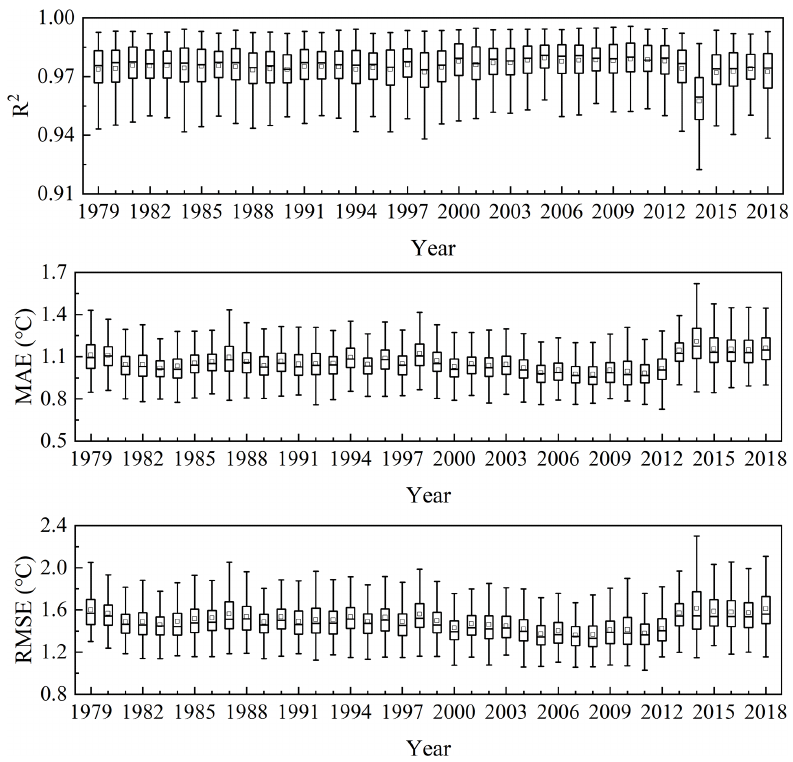
Figure 7. Box plots of the R 2 , MAE and RMSE of T max after correction for each year in the whole China region.